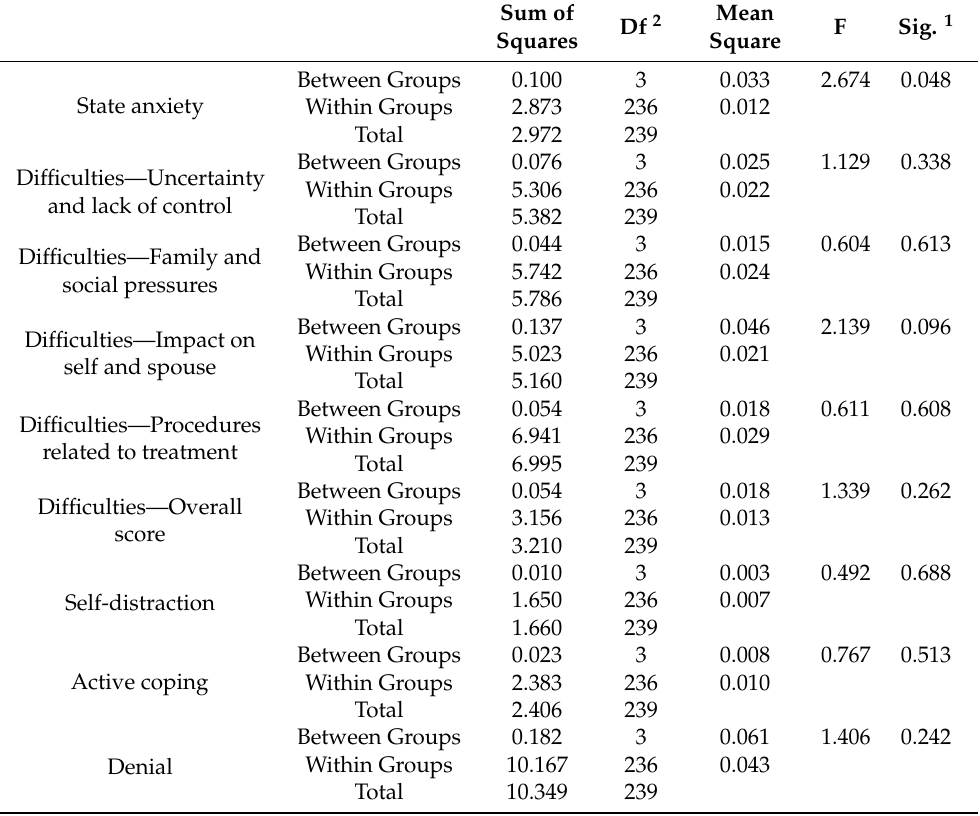
Table 6. Analysis of the variance of anxiety, difficulties, and coping scores of the women in the study according to the cause of